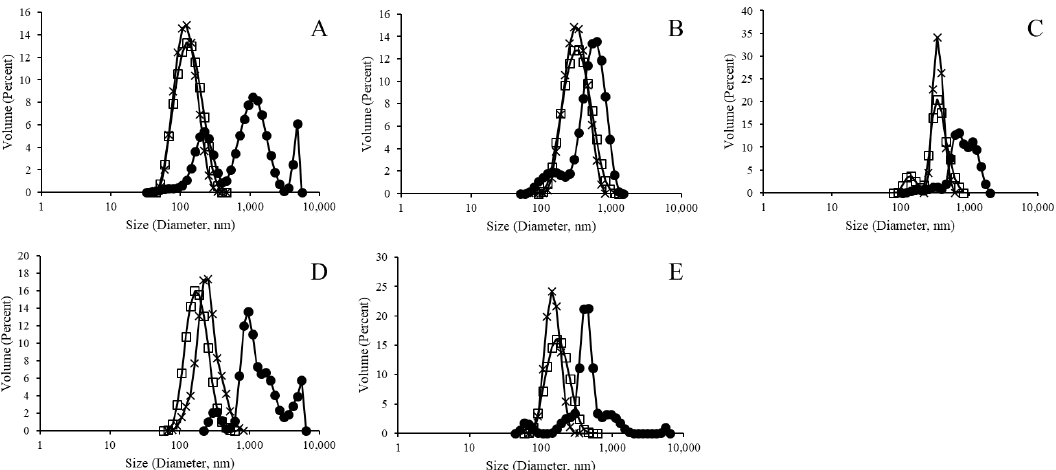
Figure 4. Post-purification size distribution analysis of polysaccharide 19F encapsulated liposomes. Closed circles, open squares, and × signs, respectively, represent pre-extrusion, post-extrusion, and post-purification liposomes without metallic binding element (( A ) PDI: 0.90, 0.15, 0.29), and with Ni